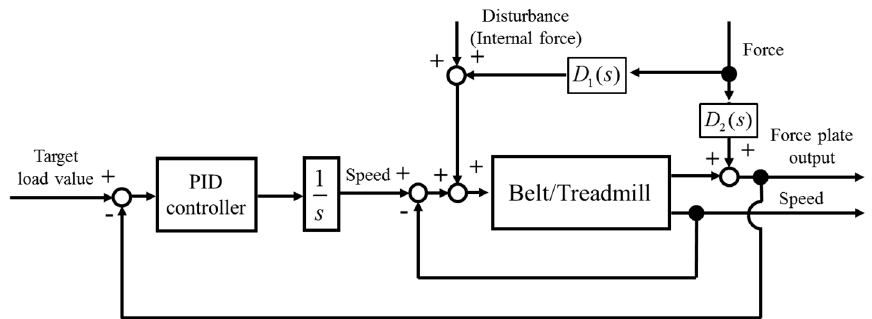
Figure 2. Block diagram for load control system in the treadmill installed with a force